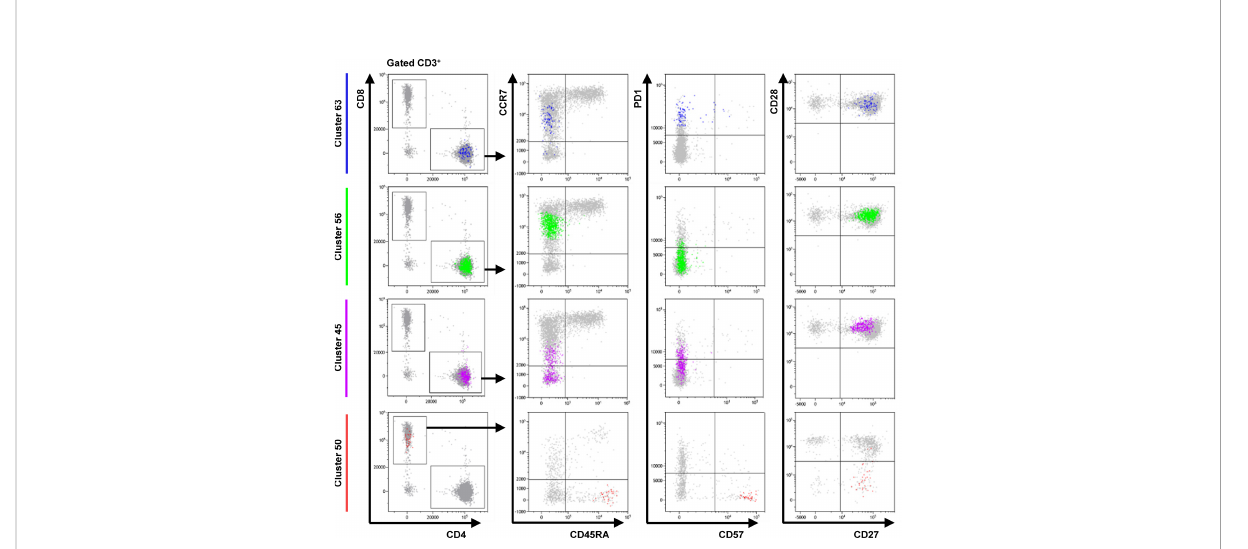
FIGURE 3 Phenotype of cells in FlowSOM clusters associated with colitis. Dot plots show the phenotype of the cells in each cluster (color) and all gated cells for reference (grey). Clusters 63 and 56 are CD4 + CD45RA - CCR7 int CD27 + CD28 + CD57 - T cells that differ only in expression of PD-1. Cluster 45 is CD4 + CD45RA - CCR7 low/- PD-1 int CD27 + CD28 + CD57 - T cell population. Cluster 50 represents a CD8 + CD45RA + CCR7 - CD27 + CD28 - PD-1 - CD57 + T EMRA subpopulation. Data from one representative